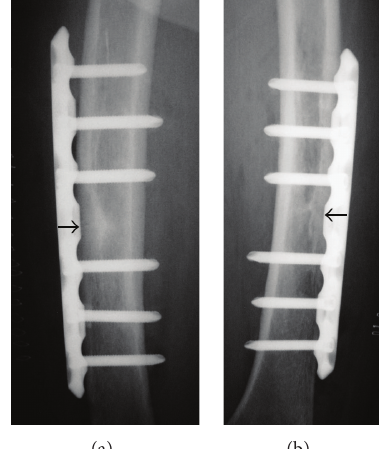
Figure 5: Anteroposterior radiographs of the bilateral femurs treated surgically using locking plates. Black arrows show original horizontal line.